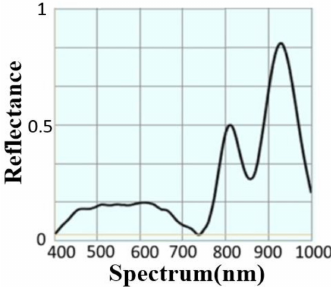
Figure 5. The reflectance spectrum of MSSMD measured on the diffuse reflectance standard white- board